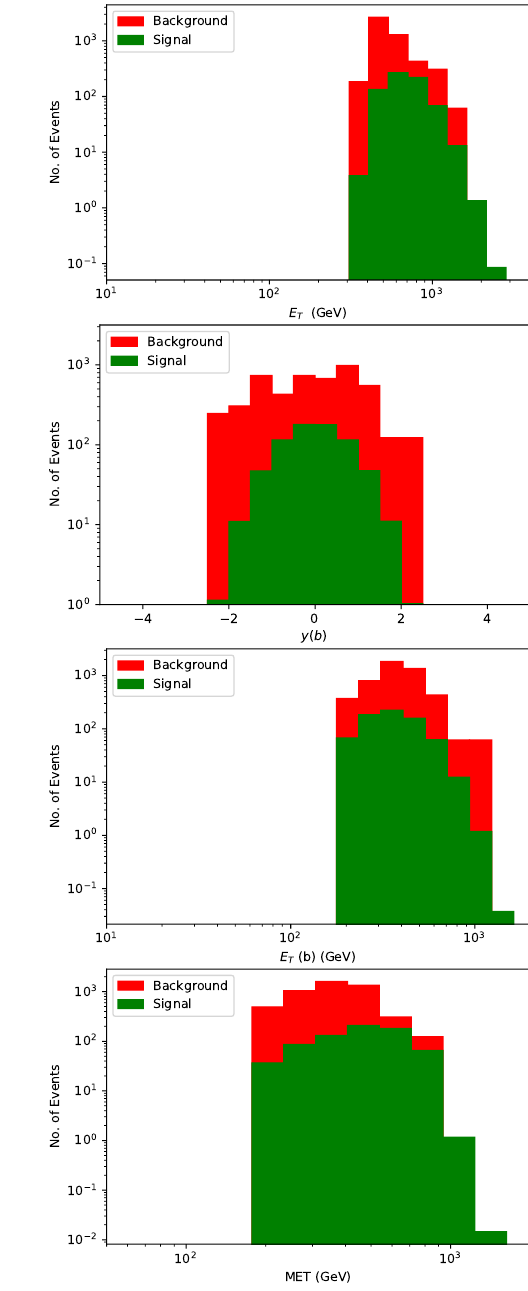
Figure 6 . Parton level event distributions for pp → ¯ q 0 q 0 → ¯ bbH 0 an integrated luminosity of 300 fb − 1 along with the SM background (in red), here q 0 represents all the exotic quarks i.e., d 0 , s 0 , b 0 . (Left column, top to bottom): the total transverse energy E T , the rapidity y , the total transverse energy of the b quark, E T ( b ) , and the missing transverse energy /E before cuts. (Right column, top to bottom): the same distributions after implementing the cuts in table 12, which reduce the